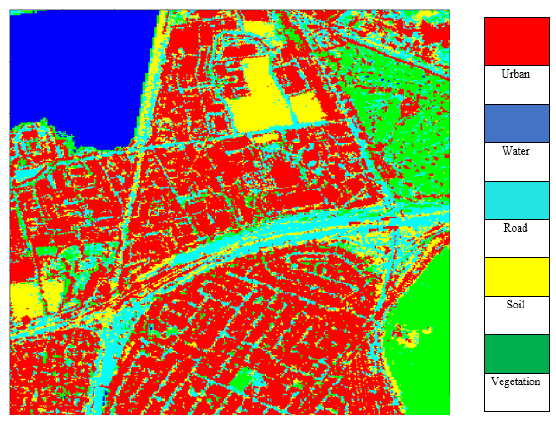
Figure 5. Land use map 1990 (b). Land use map